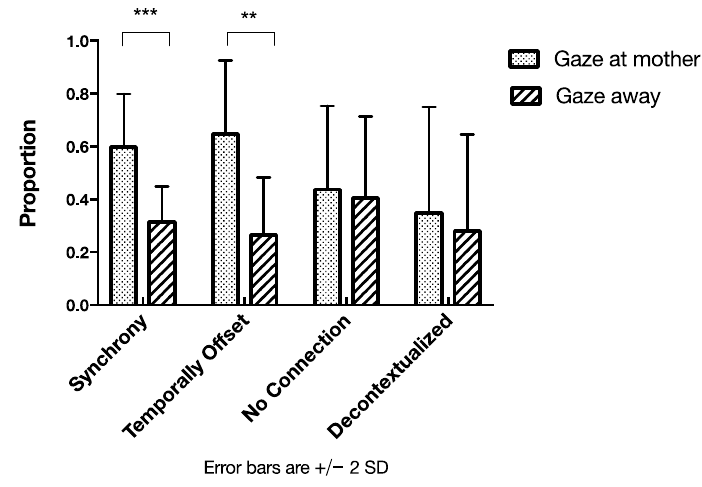
Figure 9. Types of verb–action coordination overlapping with categories of infant gaze (* p < 0.05; ** p < 0.01; *** p < 0.001).